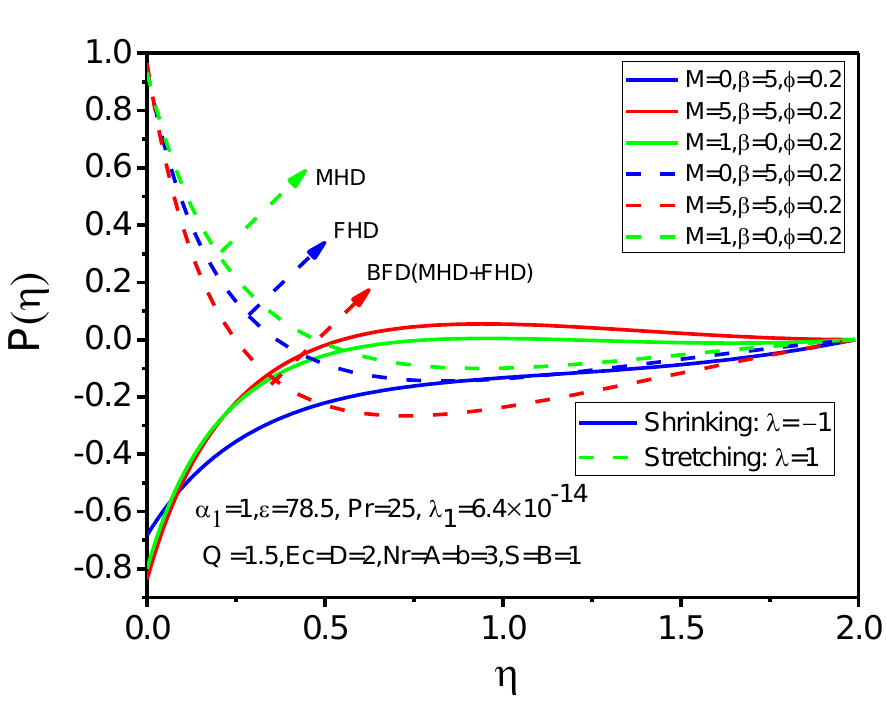
Figure 2. Velocity profile for BFD, MHD and FHD.